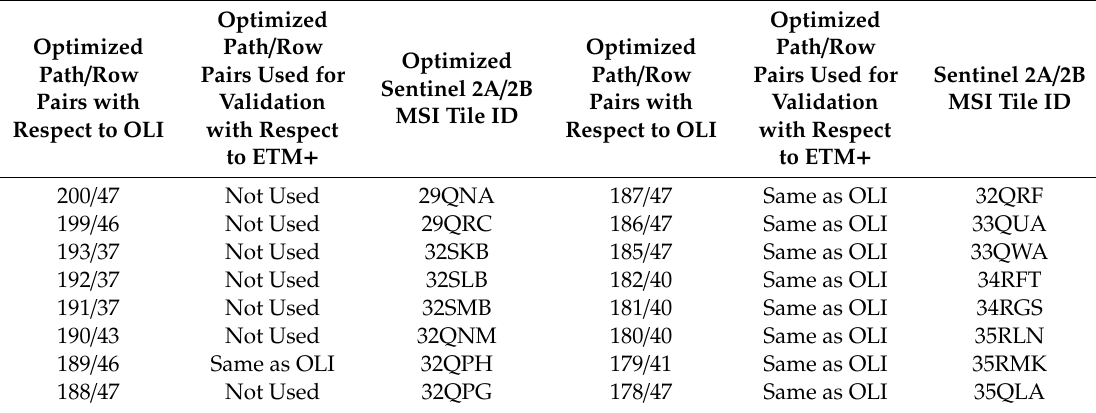
Table 6. Path / row images (OLI, ETM + ) and tile images (MSI-A, MSI-B) used for